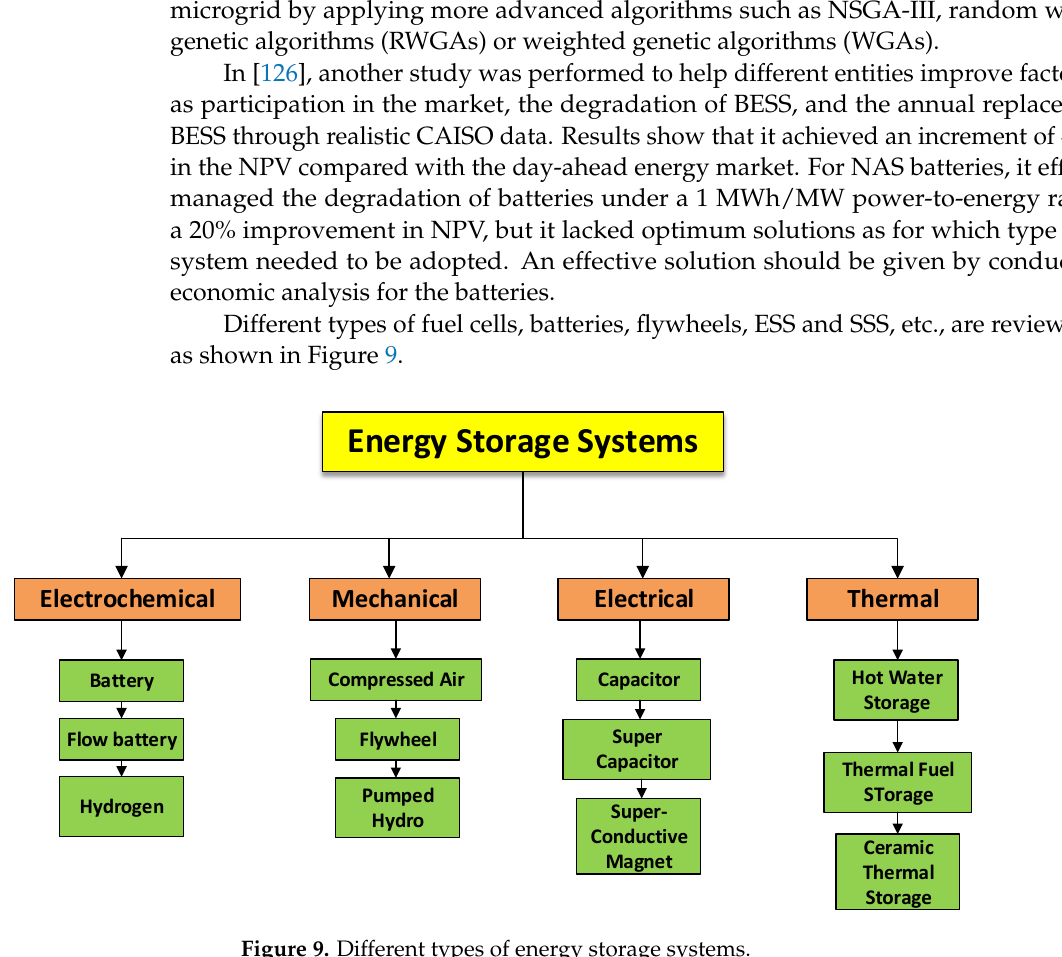
Figure 9. Different types of energy storage systems.